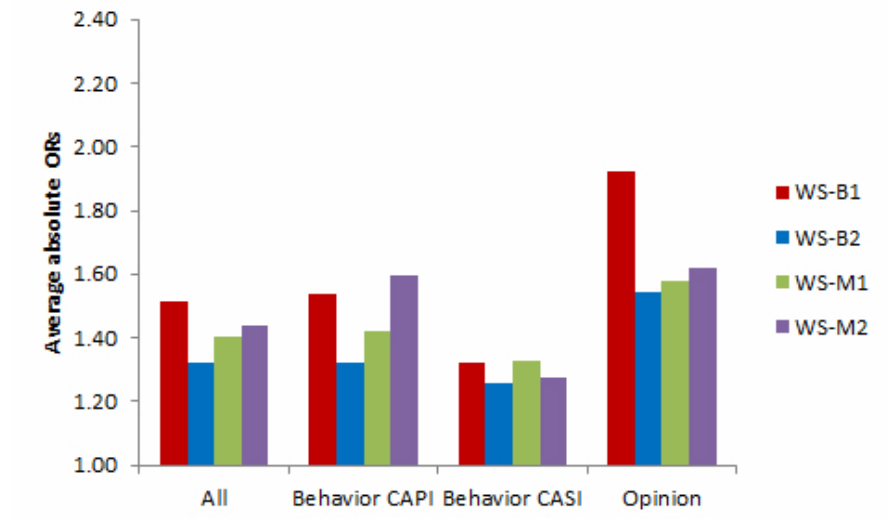
Figure 3. Women: Summary of average absolute ORs for behavior (CAPI and CASI) and opinion variables for the 4 Web surveys compared with Natsal-3.